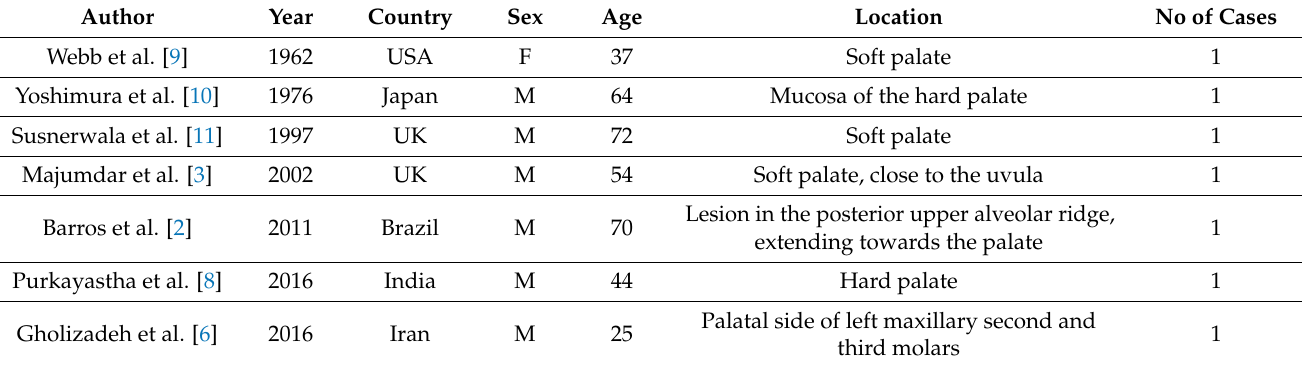
Table 1. Summary of previous reports of extramedullary plasmacytoma (EMP) with the involvement of the palate.